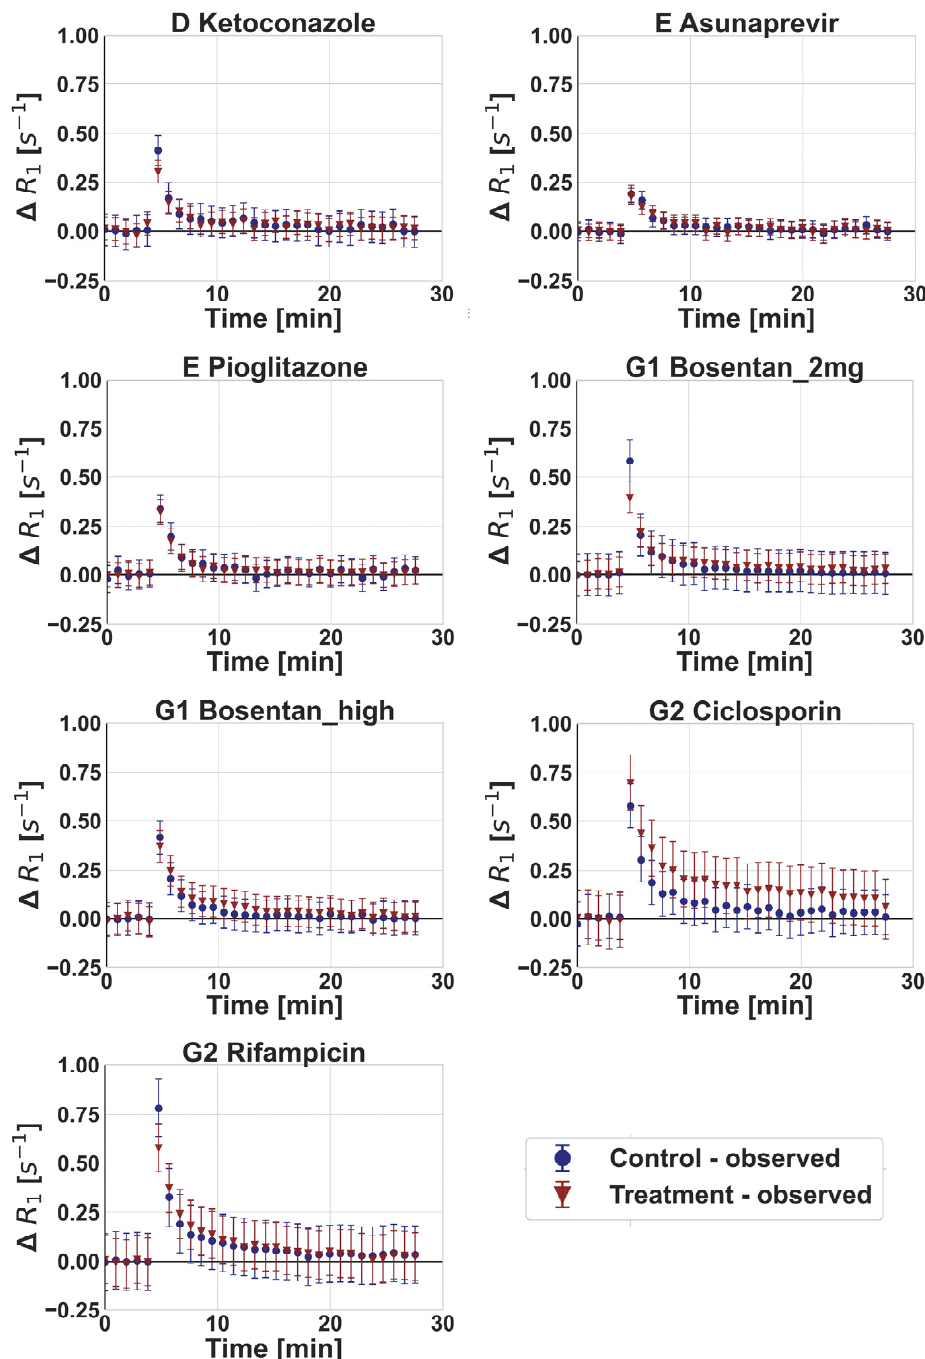
Figure 4. Observed gadoxetate plasma profiles in control phase and following administration of drugs (treatment) at different sites (D, E, G1, and G2). Symbols and error bars represent mean and standard deviation (between 3 and 6 animals), respectively. Doses for each drug are listed in Table 1, where Bosentan_high refers to the 4–6 mg/kg doses of bosentan.